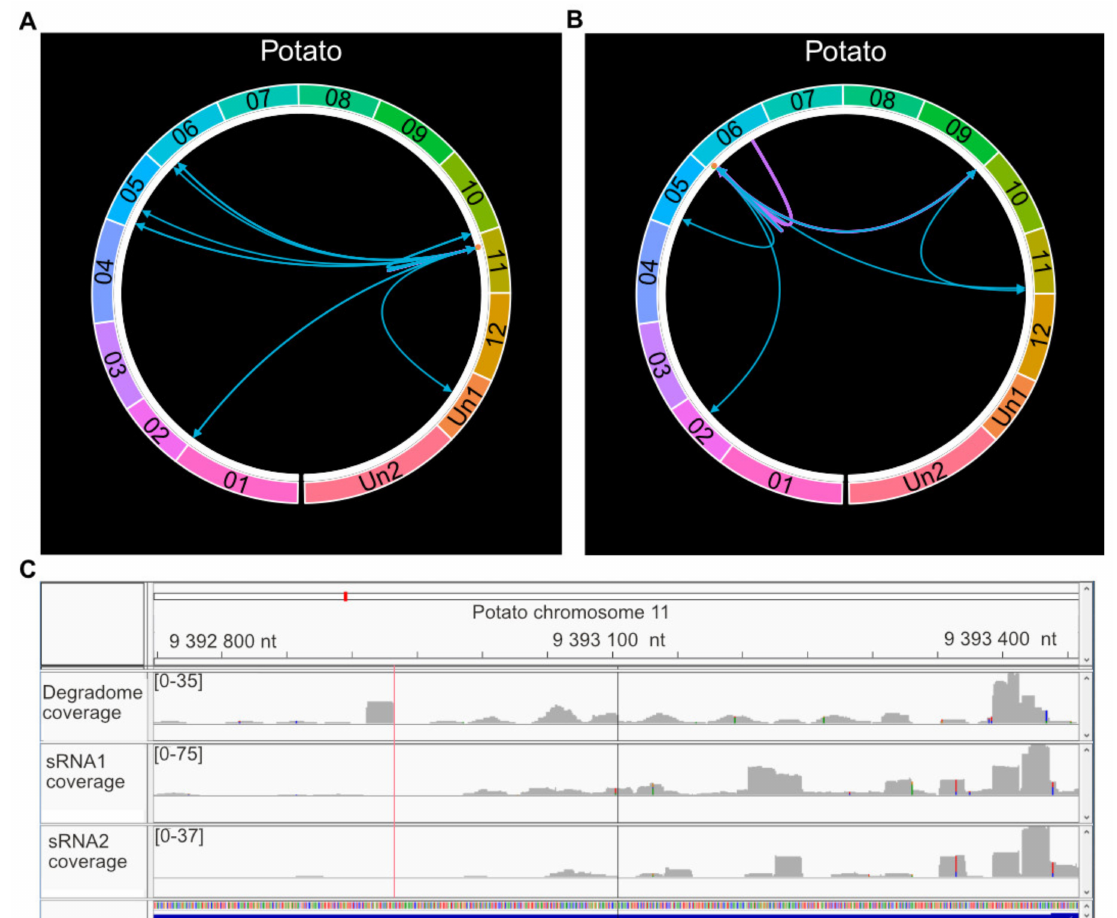
Figure 6. Precursor and target sites of sRNAs in cascade